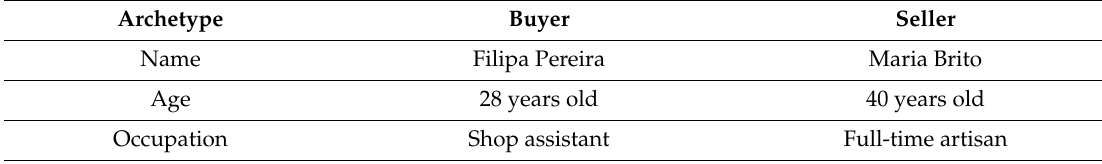
Table 1. Archetypes. Self-source,